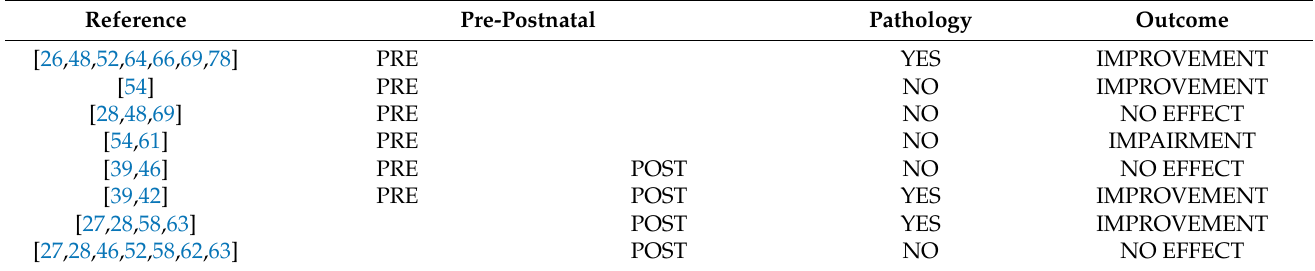
Table 2. Articles that used the Morris water maze to assess the dietary choline effect. Prenatal–postnatal supplementa- tion (PRE/POST), animal model of pathology (YES/NO) and treatment outcome (improvement/impairment/no effect). Note that the control groups without pathological conditions included in studies using pathological conditions are also considered. Pathological conditions include chronic animal models of pathologies, acute insults and deficiencies caused by prenatal/postnatal treatments and